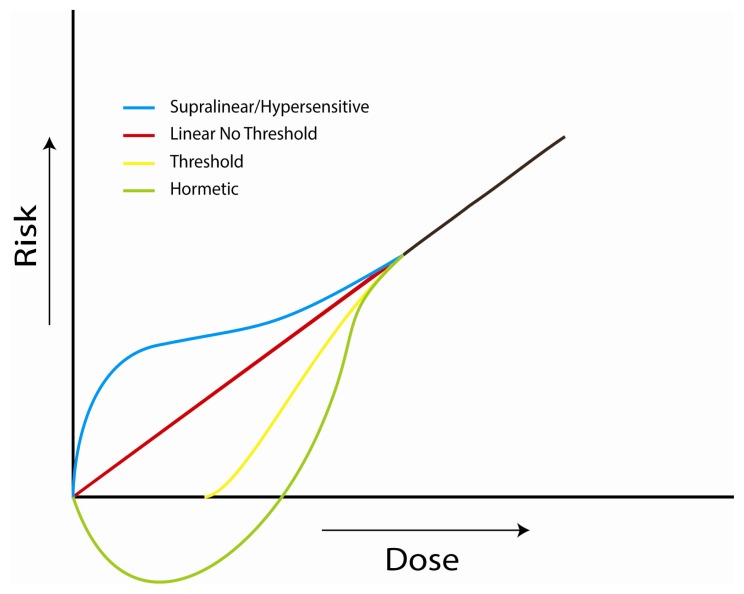
Graphical representation of some of the suggested hypotheses of dose-response functions at low doses, including hormetic, threshold, linear no threshold and supralinear (u-shaped) responses.